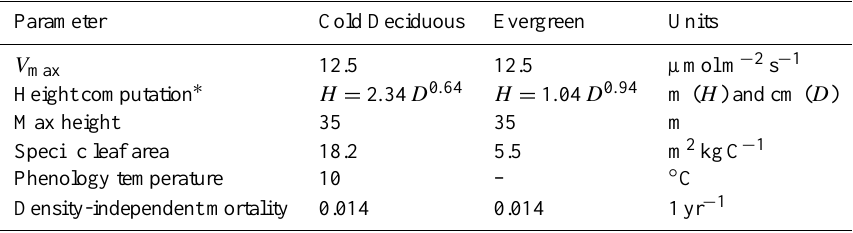
Table 4. Allometric and ecological parameters used in the ED model. The two plant functional types represent generic cold deciduous hardwood and evergreen needleleaf trees, respectively. Parameter Cold Deciduous Evergreen Units V max 12.5 12.5 µmolm − 2 s − 1 Height computation ∗ H = 2 . 34 D 0 . 64 H = 1 . 04 D 0 . 94 m ( H ) and cm ( D ) Max height 35 35 m Specific leaf area 18.2 5.5 m 2 kgC − 1 Phenology temperature 10 – ◦ C Density-independent mortality 0.014 0.014 1yr − 1 ∗ Height ( H , m) is computed based on DBH ( D ,